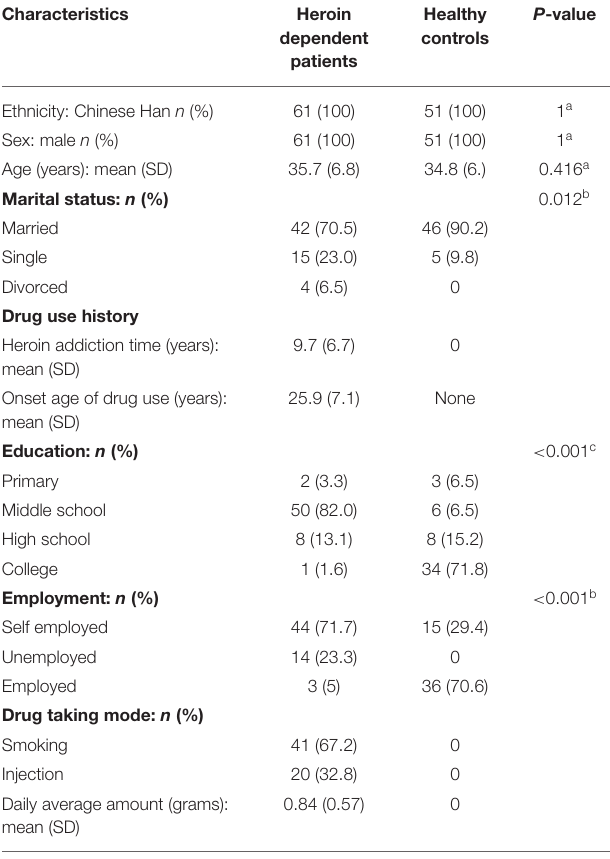
TABLE 1 | The demographic characteristics of the